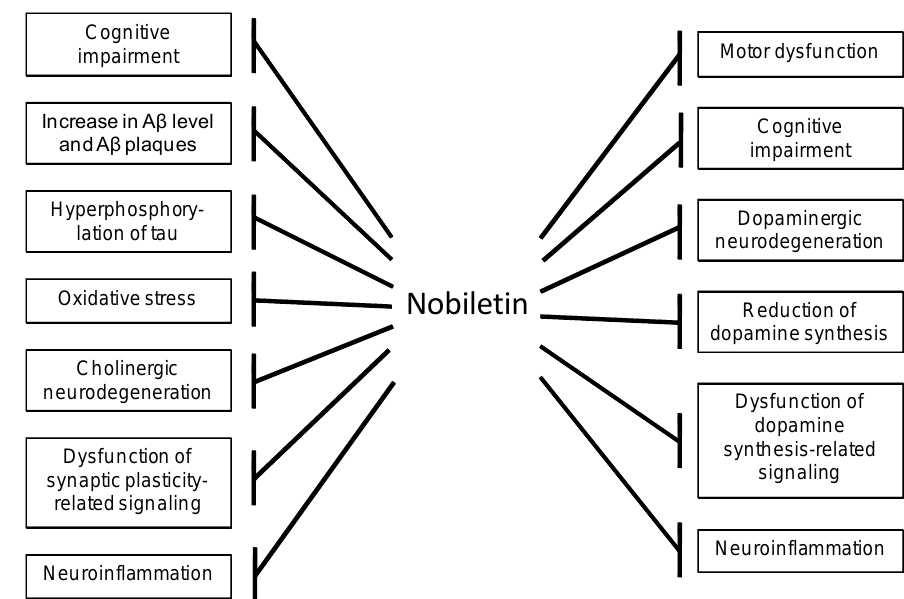
Figure 2. The wide range of beneficial effects of nobiletin against the features of Alzheimer’s disease (AD) and Parkinson’s disease (PD).